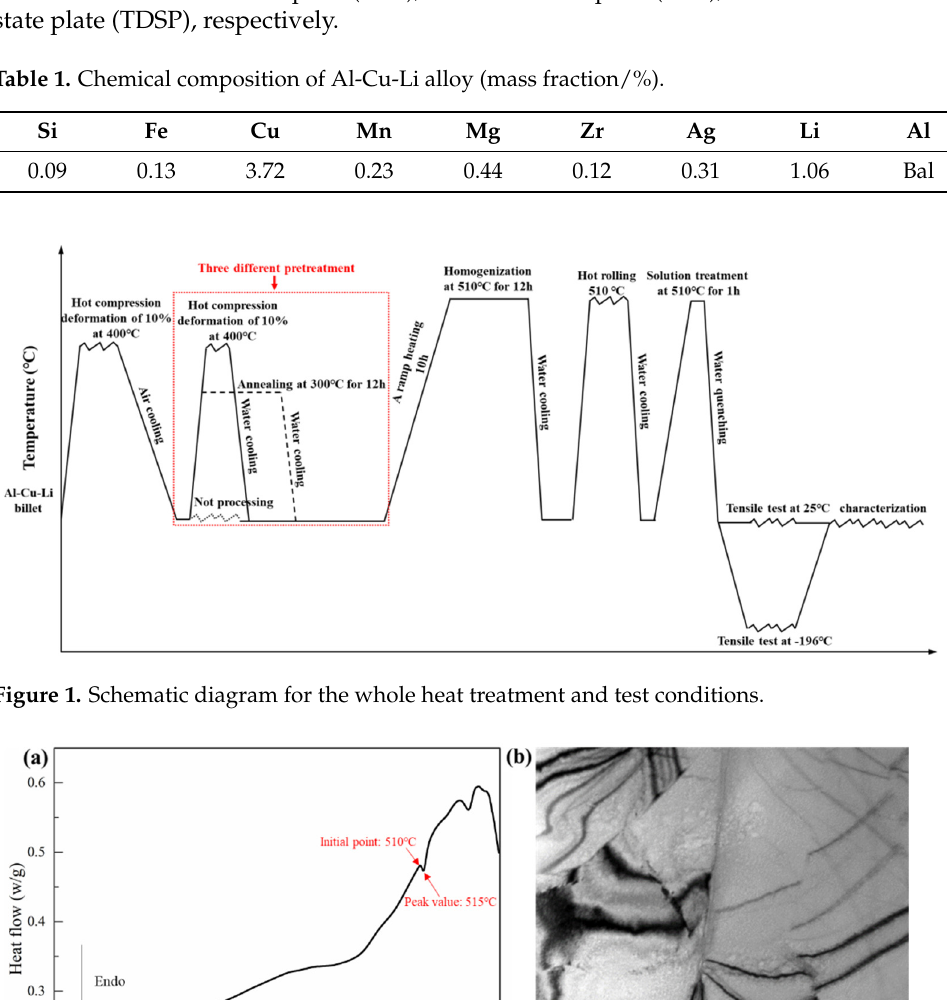
Figure 2. ( a ) DSC scan of as-cast samples of Al-Cu-Li alloy; ( b ) TEM images of the as-cast Al-Cu-Li alloy.